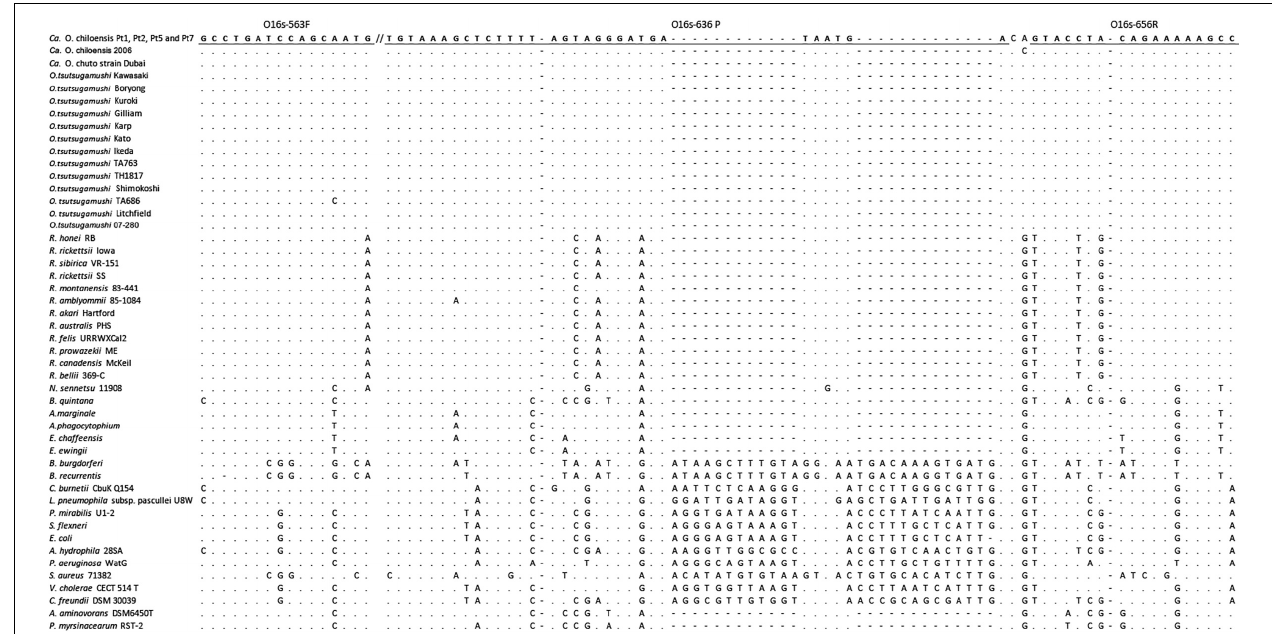
FIGURE 1 | Alignment of the rrs sequence at primer and probe